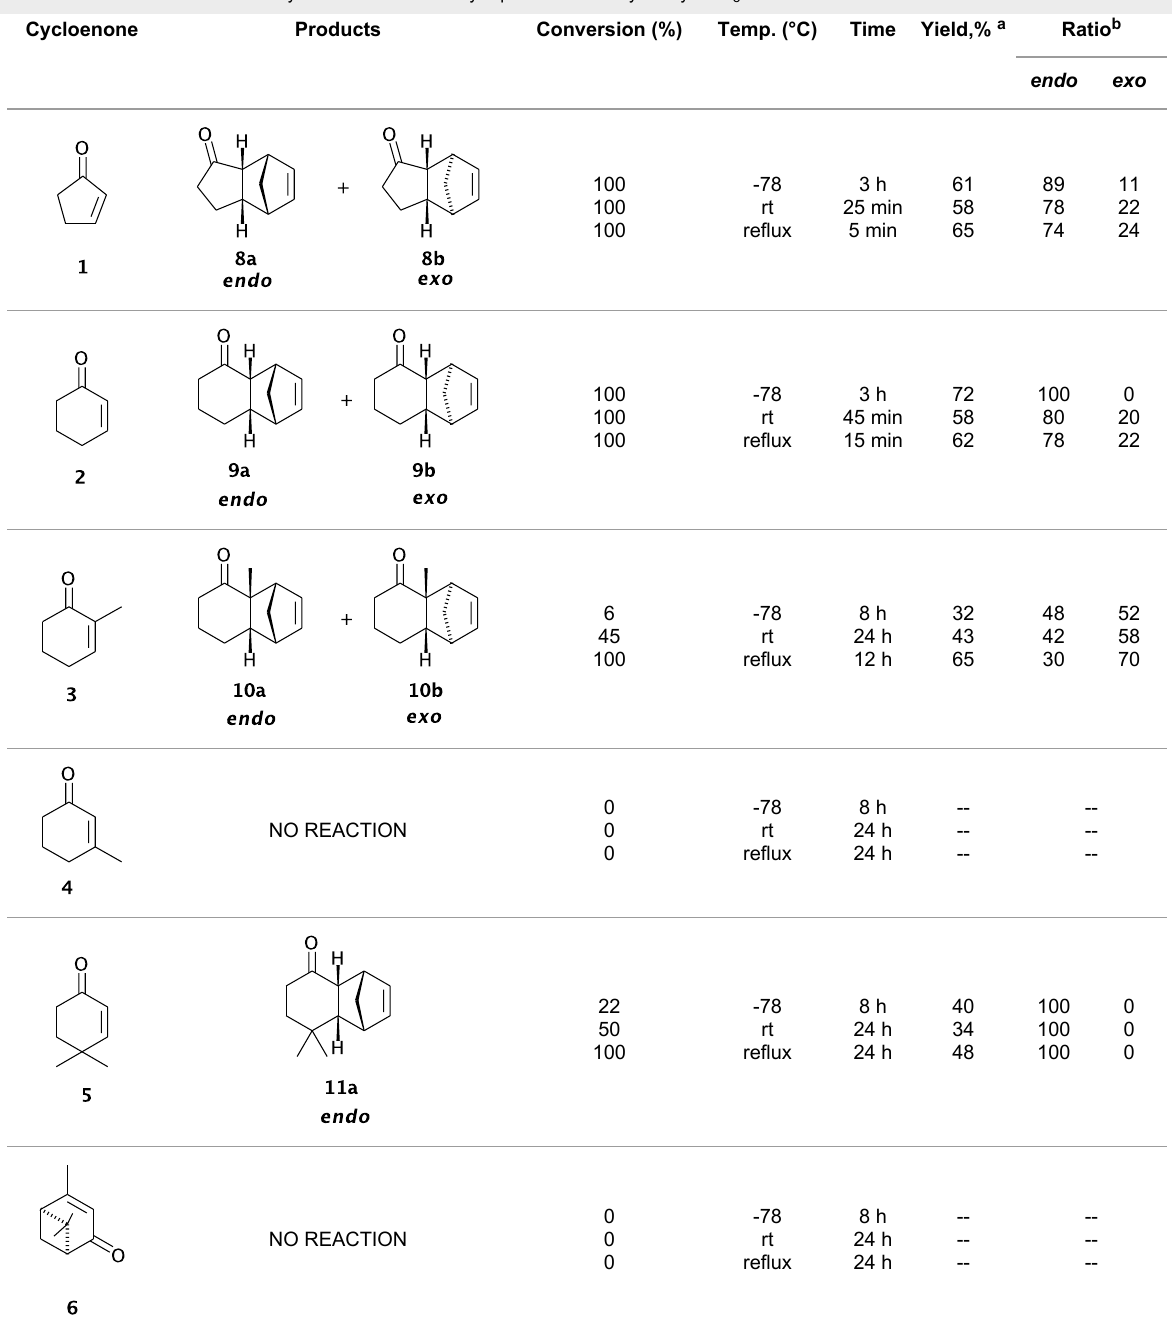
Table 1: Diels-Alder reactions of 2-cycloenones 1 – 6 with cyclopentadiene catalyzed by NbCl 5 .